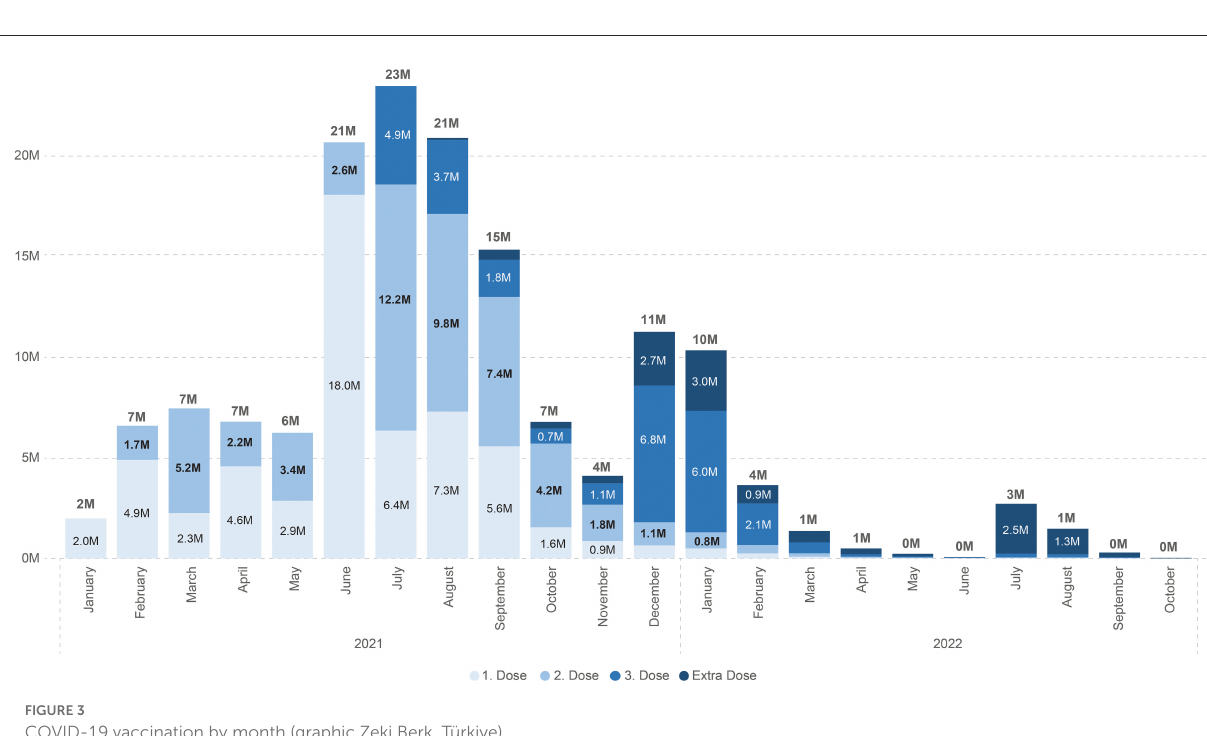
There is no indication of the Ministry having a RCCE